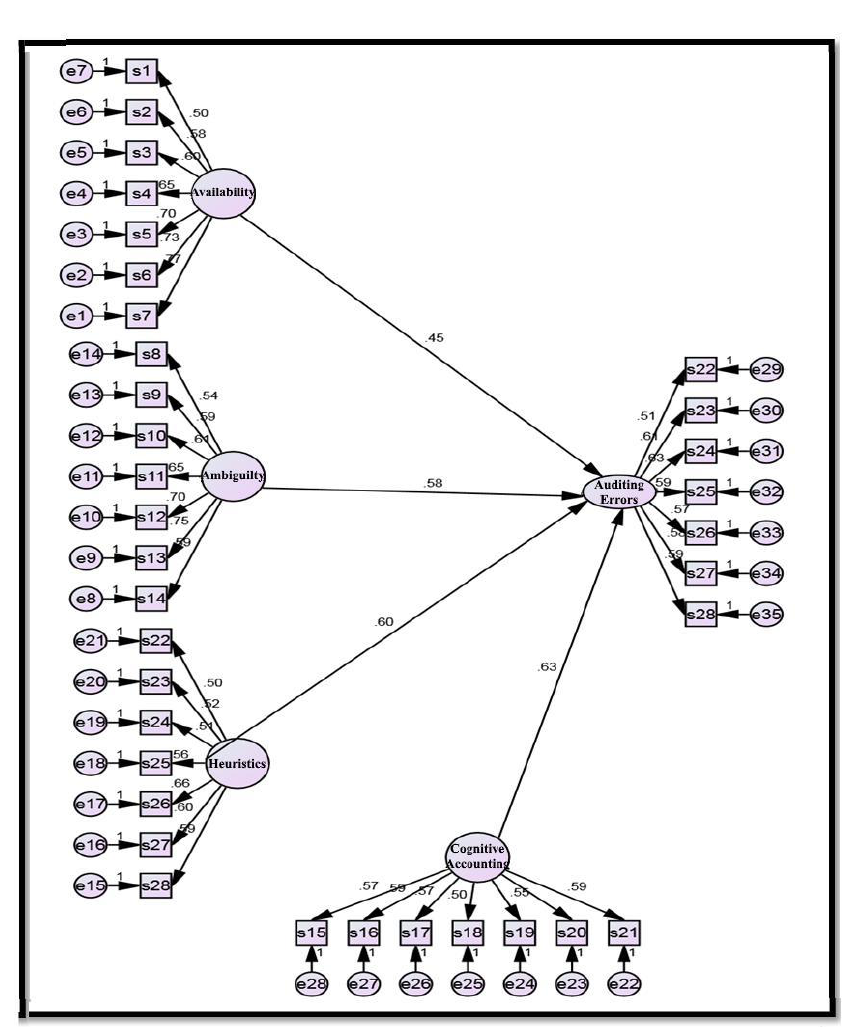
Figure (2) Analysis Findings of reviewing bias varieties role on auditors’ errors based on standardized